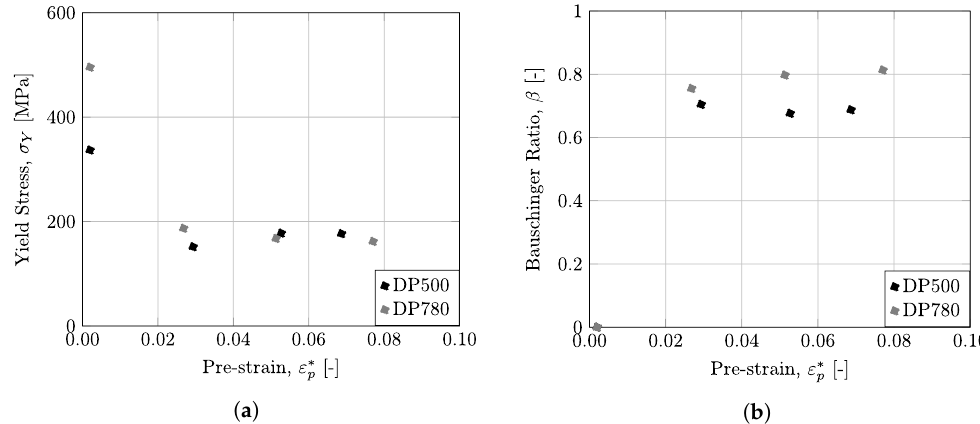
Figure 11. ( a ) Yield stress, σ Y , and ( b ) Bauschinger Ratio, β , values for different pre-strains, ε ∗ p